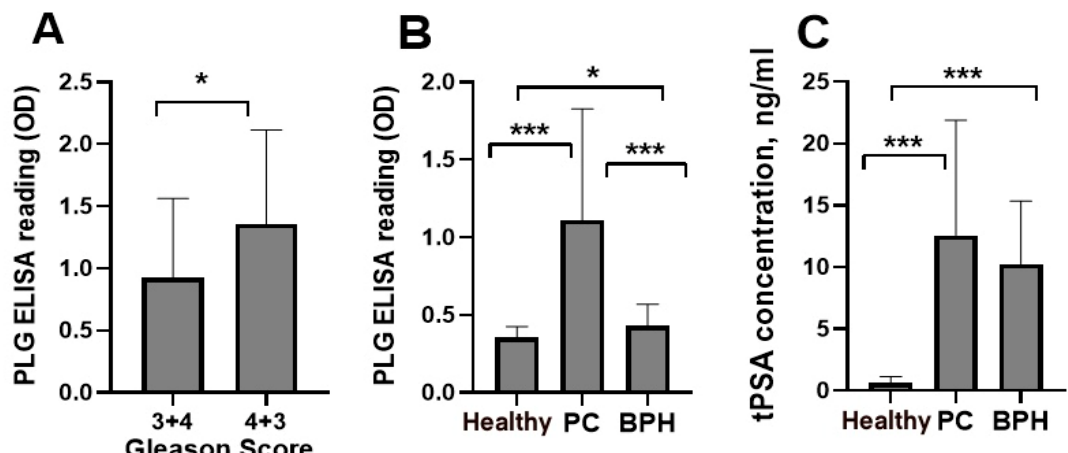
Figure 7. Circulating levels of IgG-Lys measured by PLG ELISA in PC subgroups with Gleason scores (3 + 4) vs. (4 + 3) ( A ) and in PC, BPH, and healthy controls ( B ). Circulating levels of tPSA in PC, BPH, and healthy controls ( C ). *, p < 0.05; ***, p < 0.001.